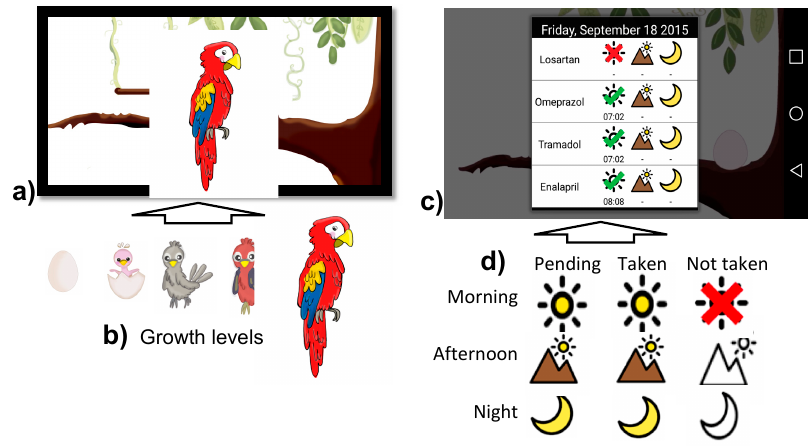
Figure 1. Medication adherence representations: ( a ) Abstract representation based on the parakeet growth; ( b ) Growth levels that a parakeet may reach during the day; ( c ) Detailed information about the medication adherence corresponding to the current day; elder or caregiver may choose a different date to consult; and ( d ) notation used to represent when medicines were taken on time, missed to take, or are pending to take diagram of the participants’ progress through the stages of each field evaluation.